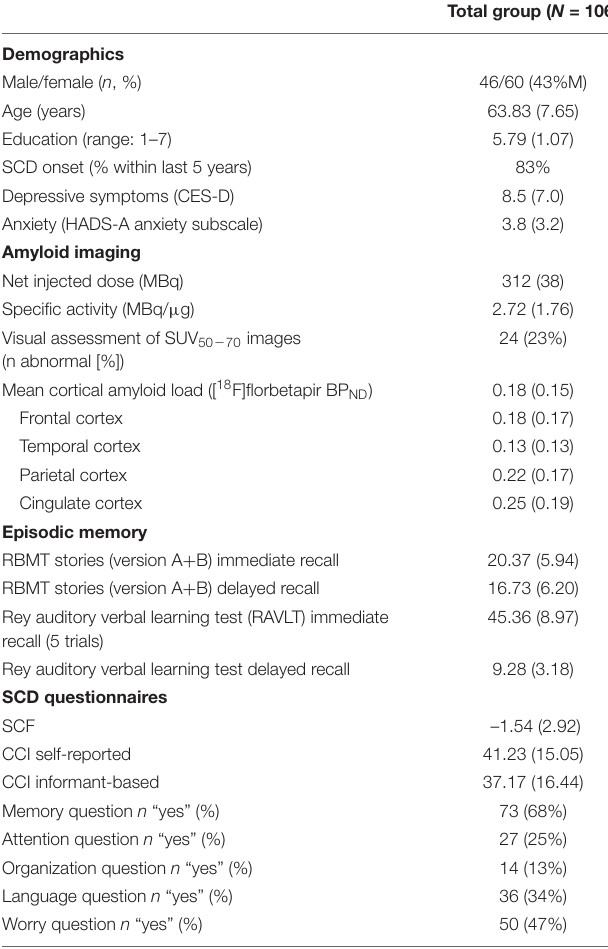
TABLE 1 | Clinical and demographic data.